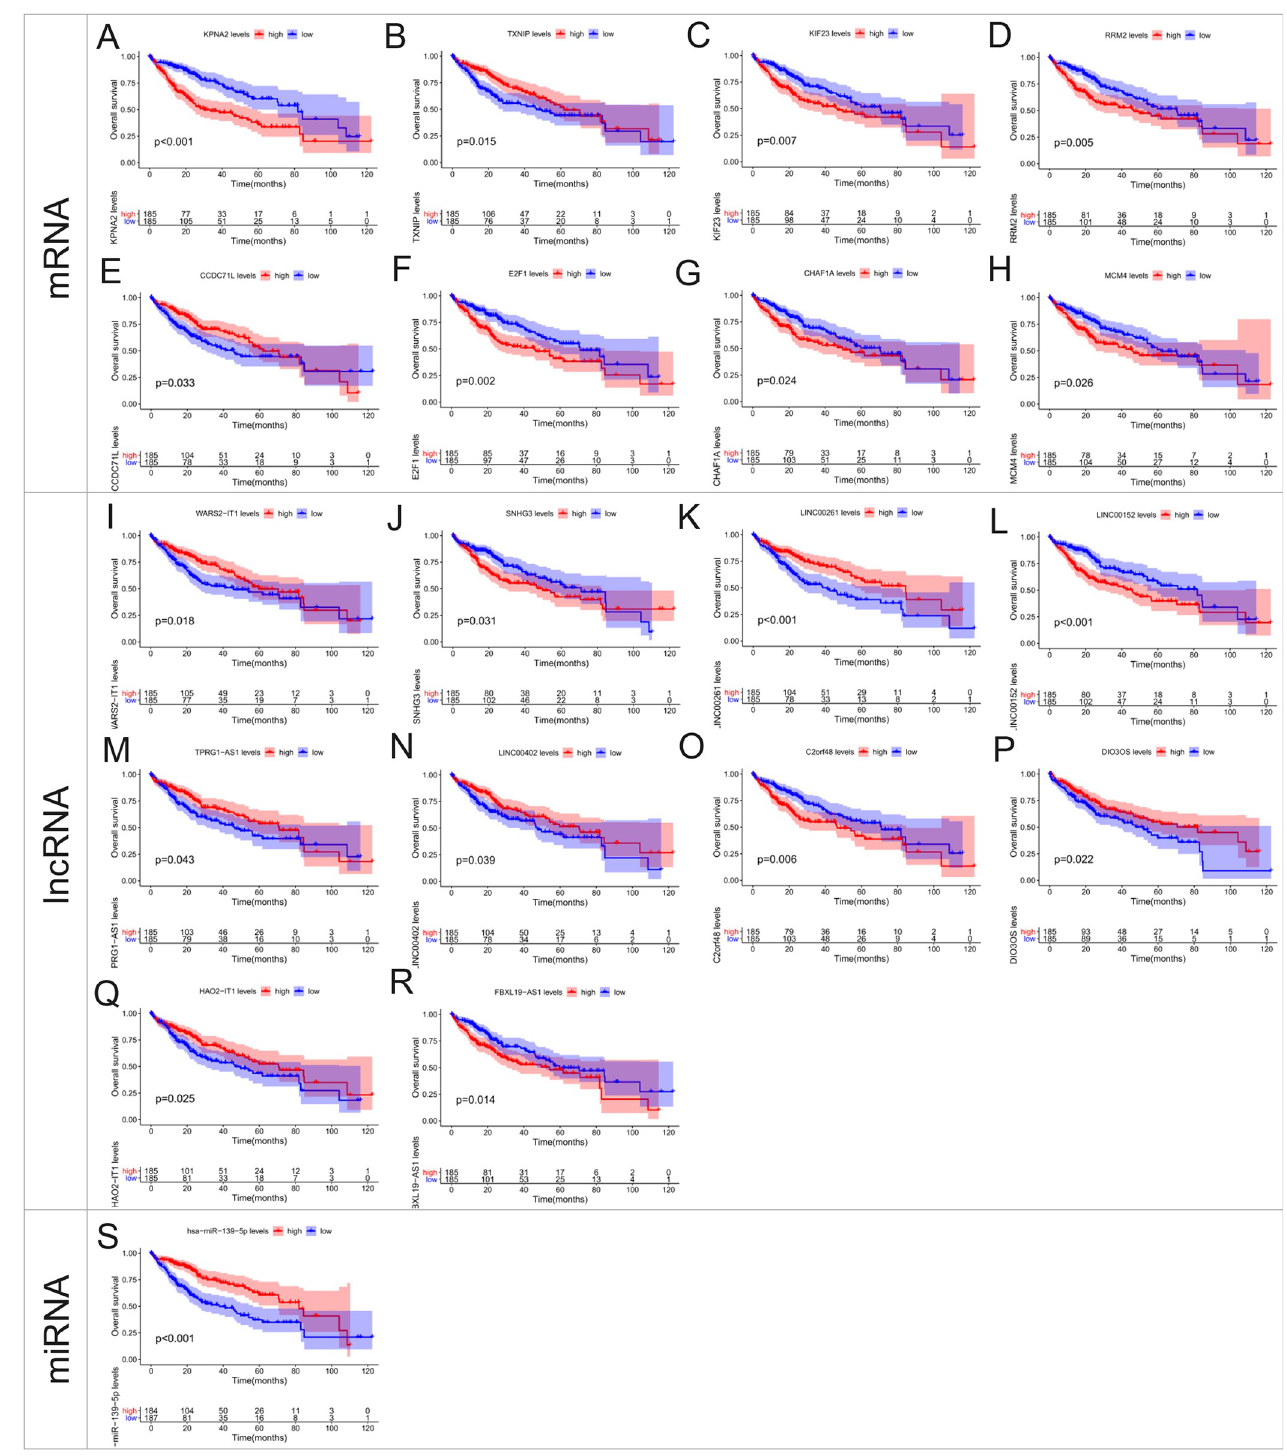
Fig 6. Kaplan-Meier survival curves for all signatures on the ceRNA network we constructed.